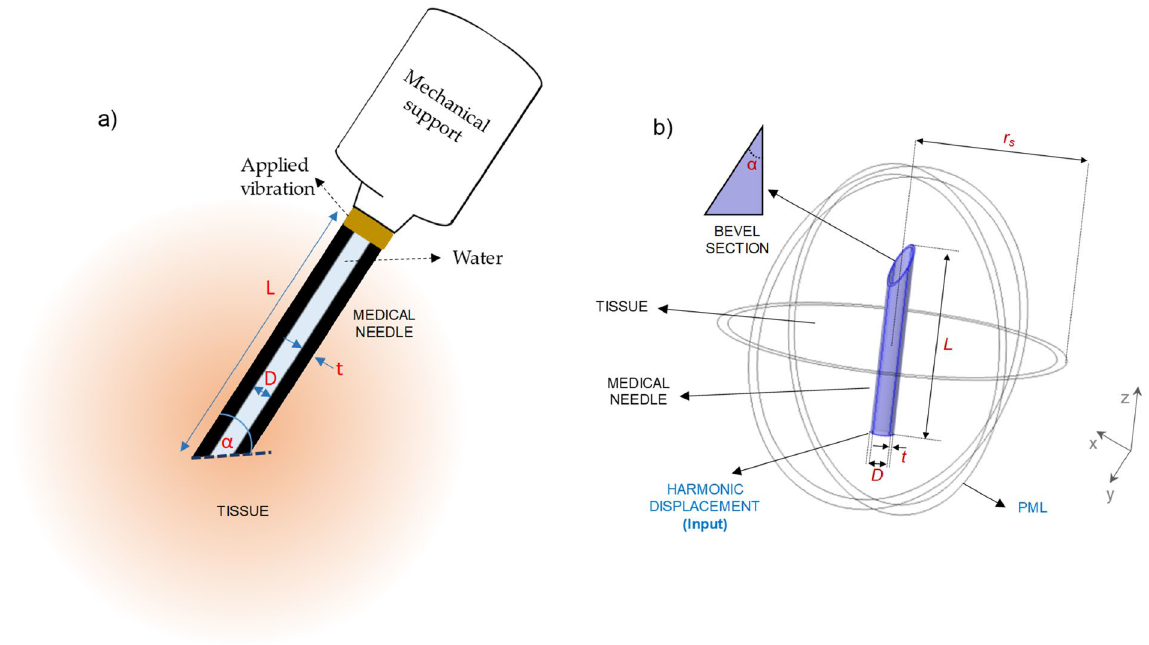
Figure 5. ( a ) Schematic representation of the studied configuration. ( b ) Simulation